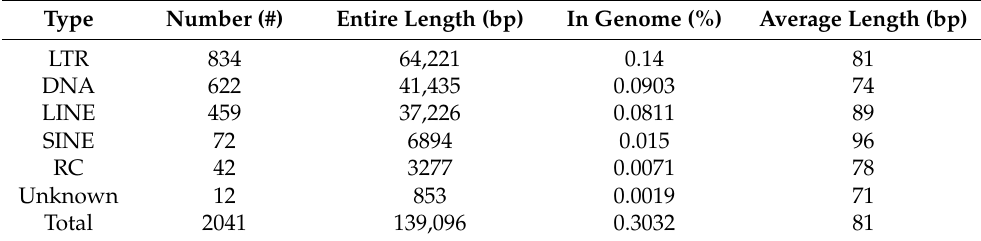
Table 2. A. rasikravindrae genome data related dispersed repeat sequences (DRs).